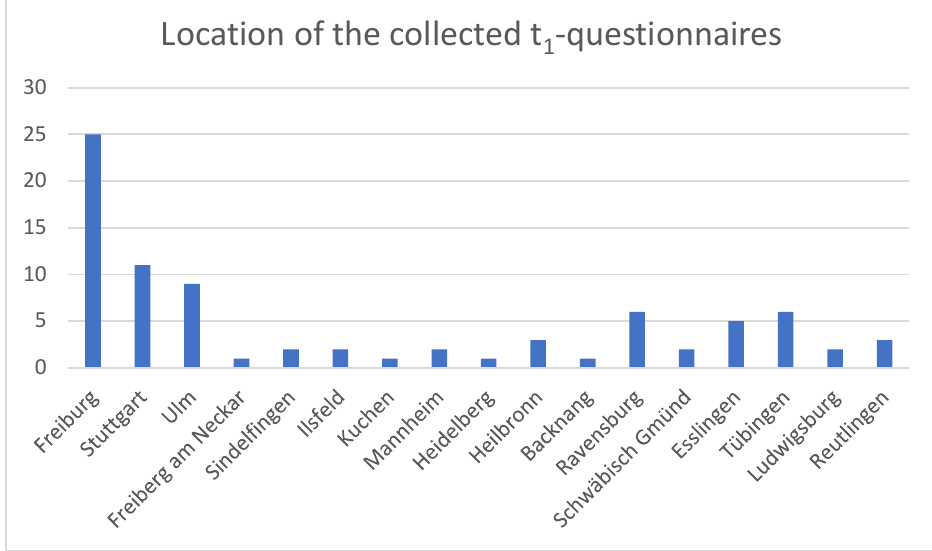
Figure 3. Spatial location of the collected t 1 -questionnaires within LINOx BW cities .